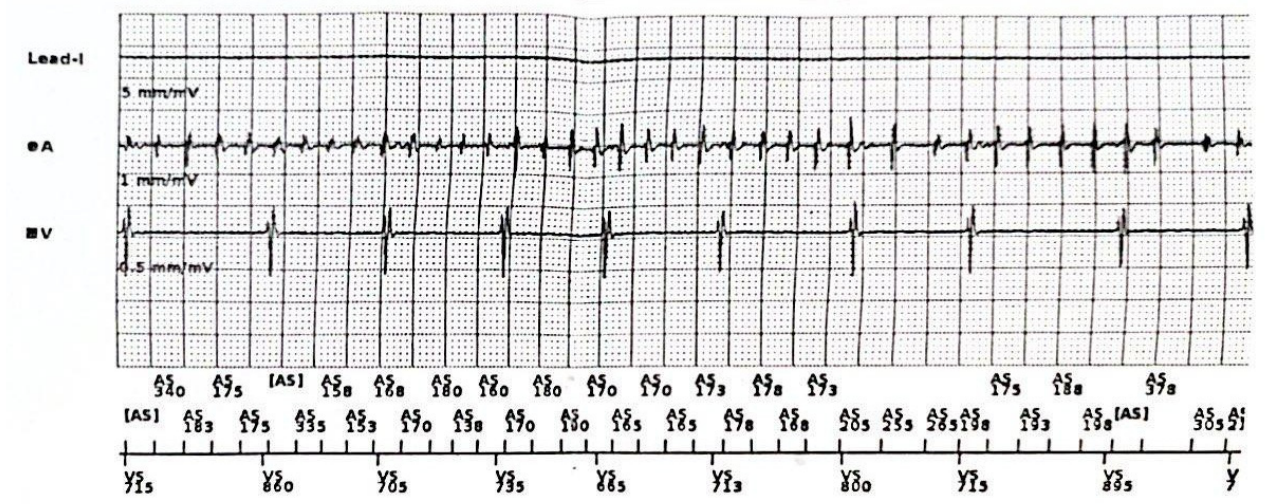
Figure 4. Ventricular bigeminism recorded during the stress test performed by the father (B.M.).